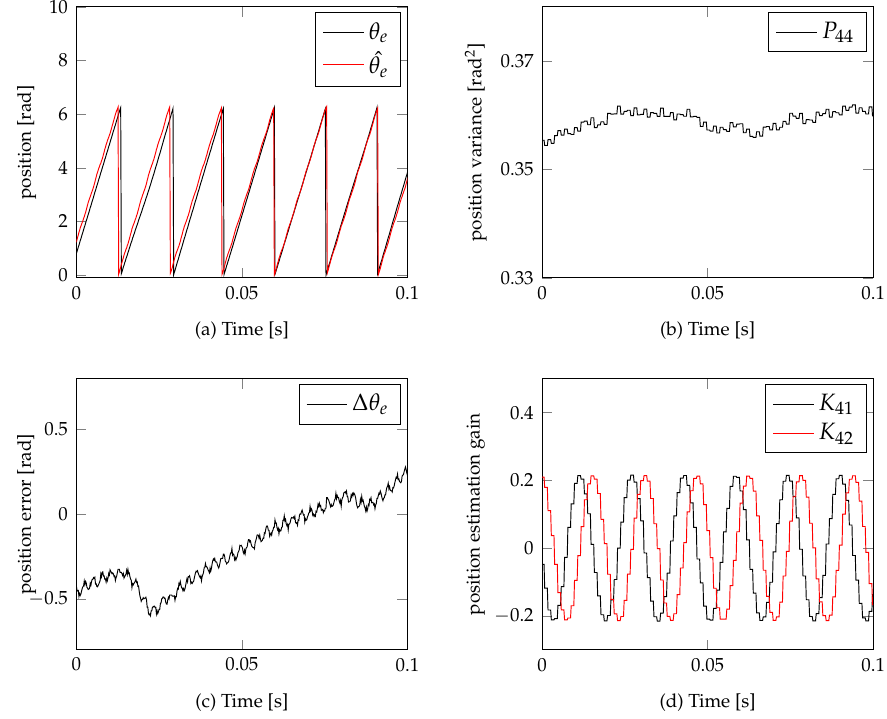
Figure 9. Experimental results ot the rotor position estimation performance at f b = 1 kHz, f s = 5 kHz and w e = 400 rads. ( a ) measured and estimated rotor positions, ( b ) estimated position error, ( c ) esti- mated position variance, ( d ) position estimation Kalman